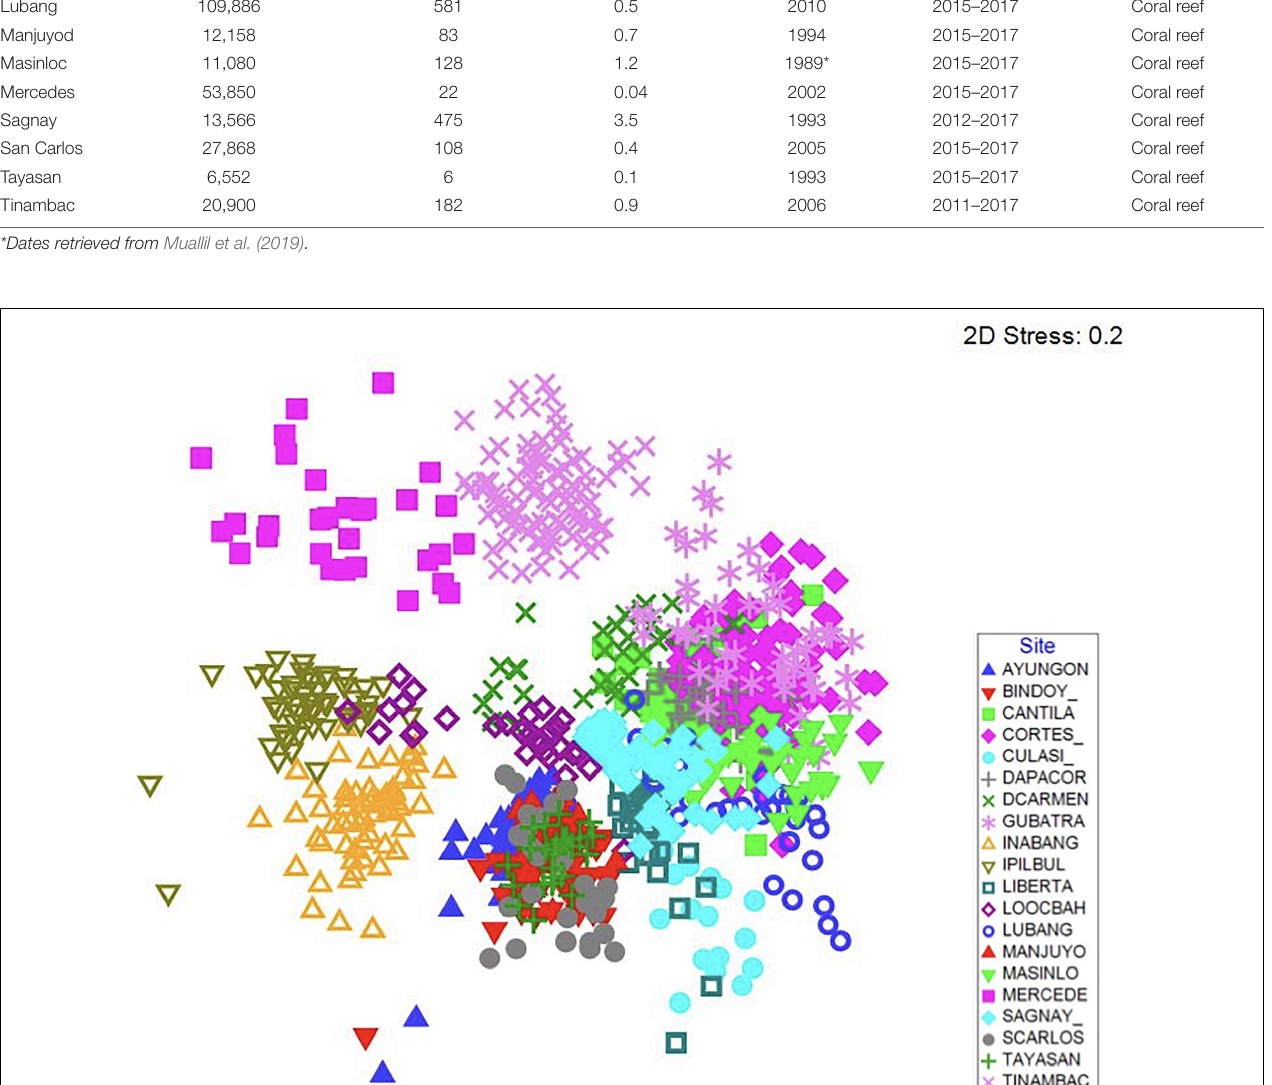
Frontiers in Marine Science |